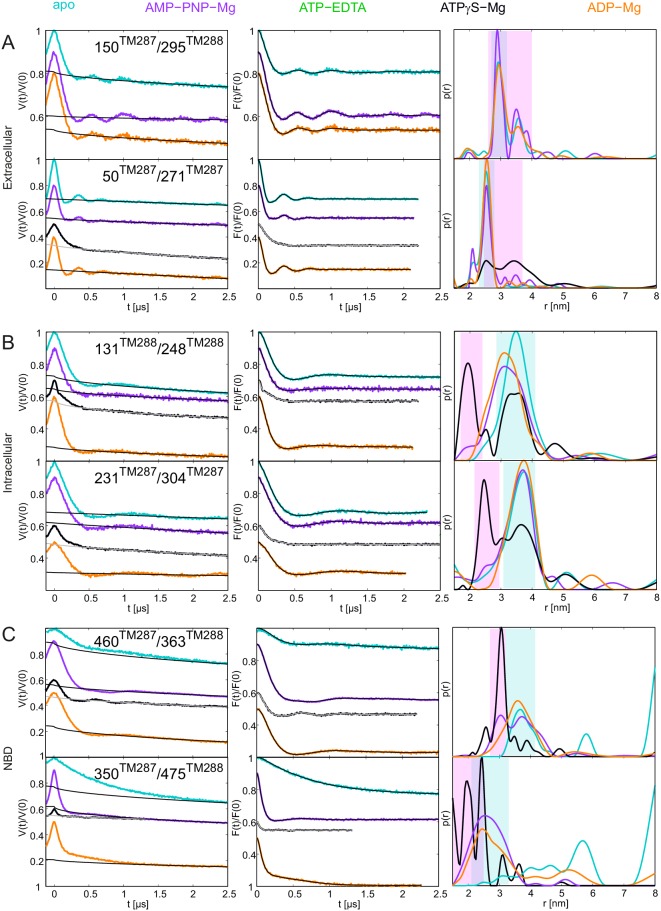
DEER analysis of wildtype TM287/288 snap frozen from 80°C.Q-band DEER traces [V(t)/V(0)], background corrected DEER traces [F(t)/F(0)] with fitted distribution function and corresponding distance distributions (from Figure 6) for the six spin-labeled pairs engineered on wildtype TM287/288 incubated at 80°C and snap frozen in isopentane. (A) Extracellular pairs 150TM287/295TM288 and 50TM287/271TM287. (B) Intracellular pairs 131TM288/248TM288 and 231TM287/304TM287. (C) NBD pair 460TM287/363TM288 monitoring the consensus site and 350TM287/475TM288 monitoring the degenerate site.